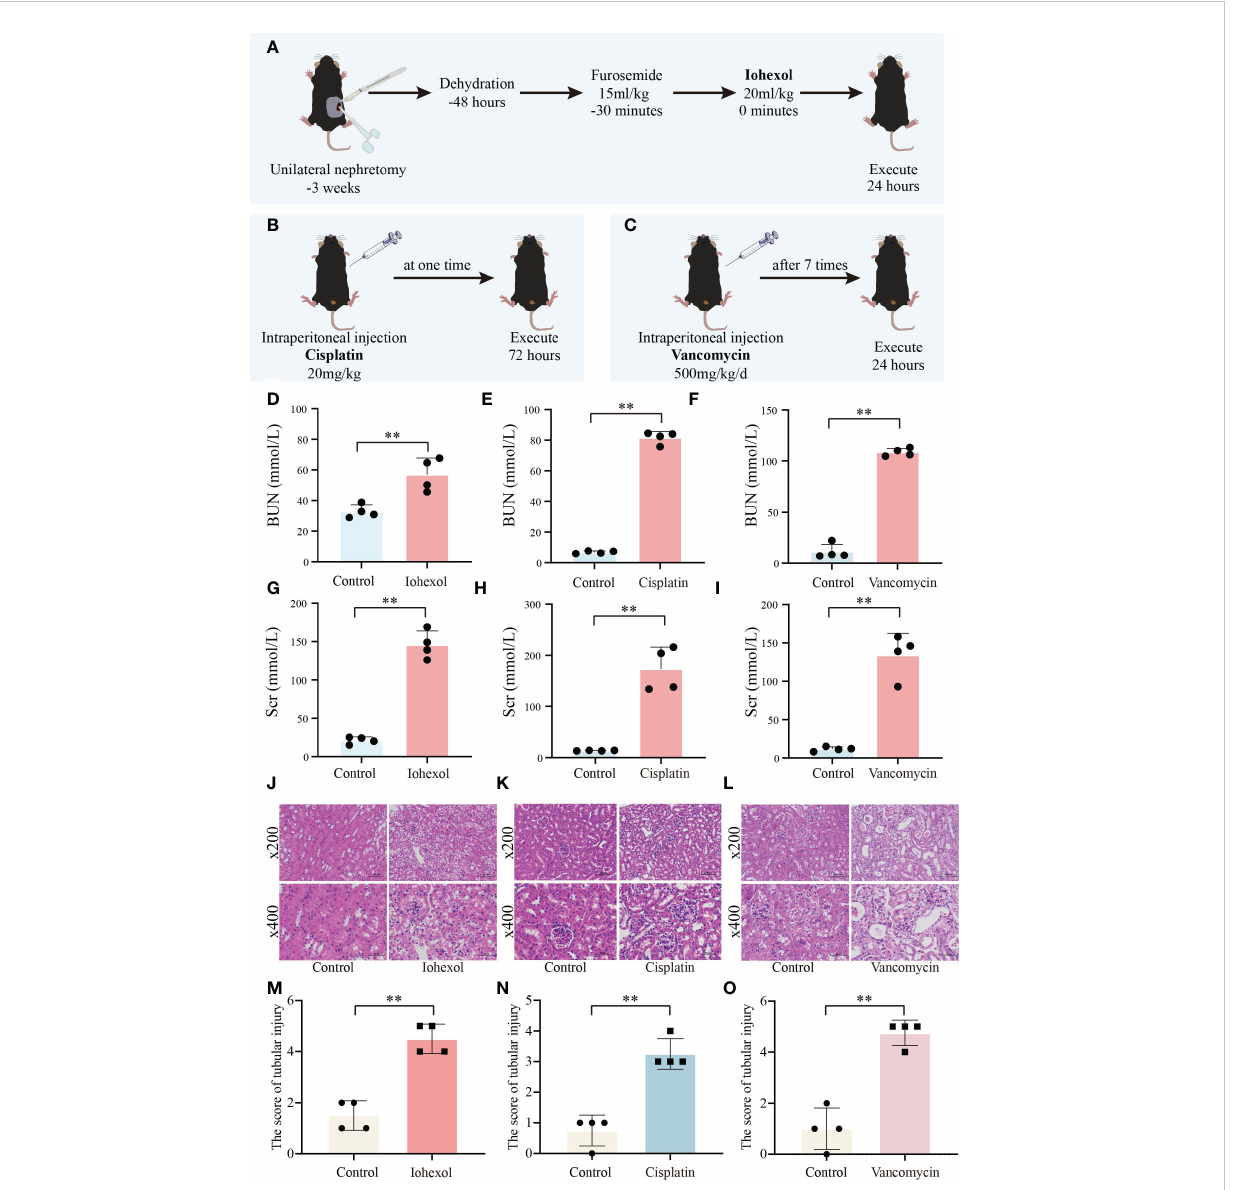
FIGURE 6 Construction and validation of AKI models. (A) Flow chart of iohexol-induced AKI model construction. (B) Flow chart of cisplatin-induced AKI model construction. (C) Flow chart of vancomycin-induced AKI model construction. (D – F) Compared to controls, BUN levels in AKI mice induced by iohexol, cisplatin, or vancomycin. (G – I) Compared to controls, Scr levels in AKI mice induced by iohexol, cisplatin, or vancomycin. BUN, blood urea nitrogen; Scr, serum creatinine. (J – O) Representative picture of HE staining and the kidney injury scores of controls, iohexol, cisplatin or vancomycin induced AKI mice. Each result was repeated four times. Compared with the control group, ** p <